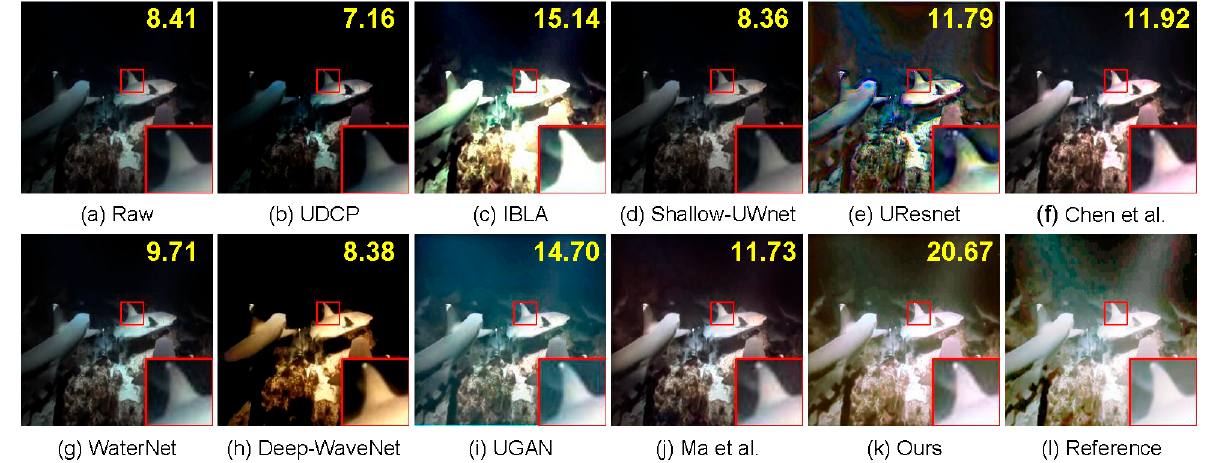
Figure 11. The visual comparisons of various UIE approaches on the low-illuminated underwater